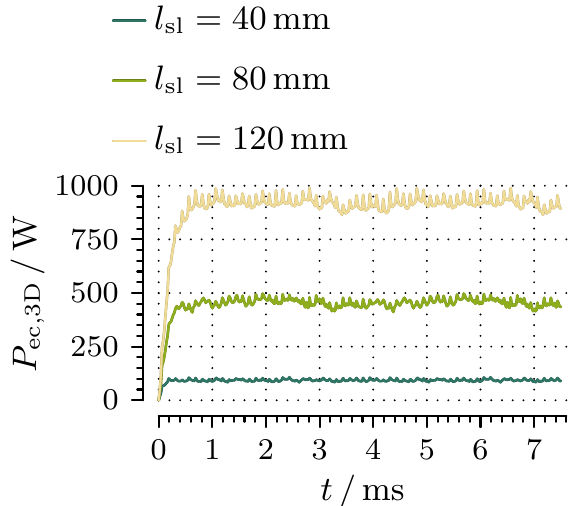
Figure 8. Transient no-load simulation results of P ec,3D obtained by AED during a single electrical period at 4000rpm for three different values of l sl .